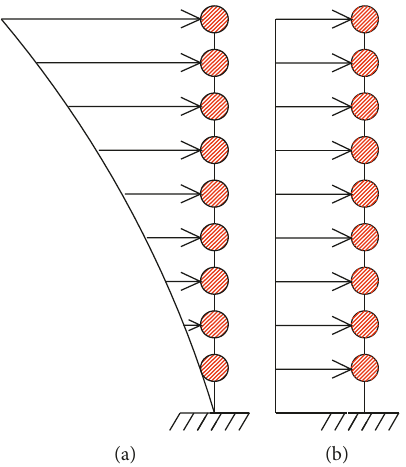
Figure 11: Lateral load distributions: (a) parabolic distribution (LD-1) and (b) uniform distribution (LD-2).